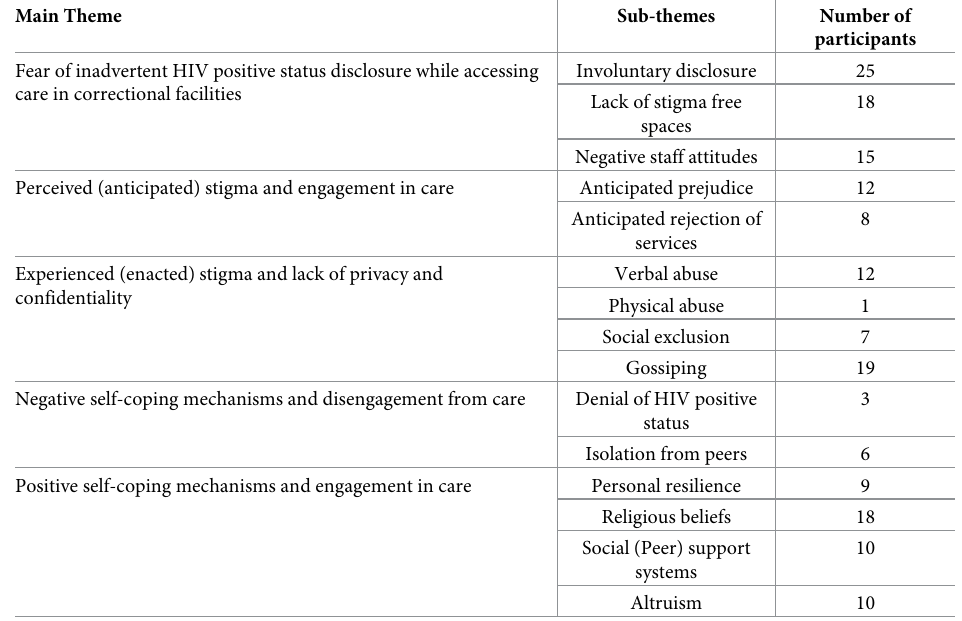
Table 3. Number of participants reporting specific themes related to HIV-related stigma in selected correctional facilities in Gauteng and Western Cape Provinces, South Africa